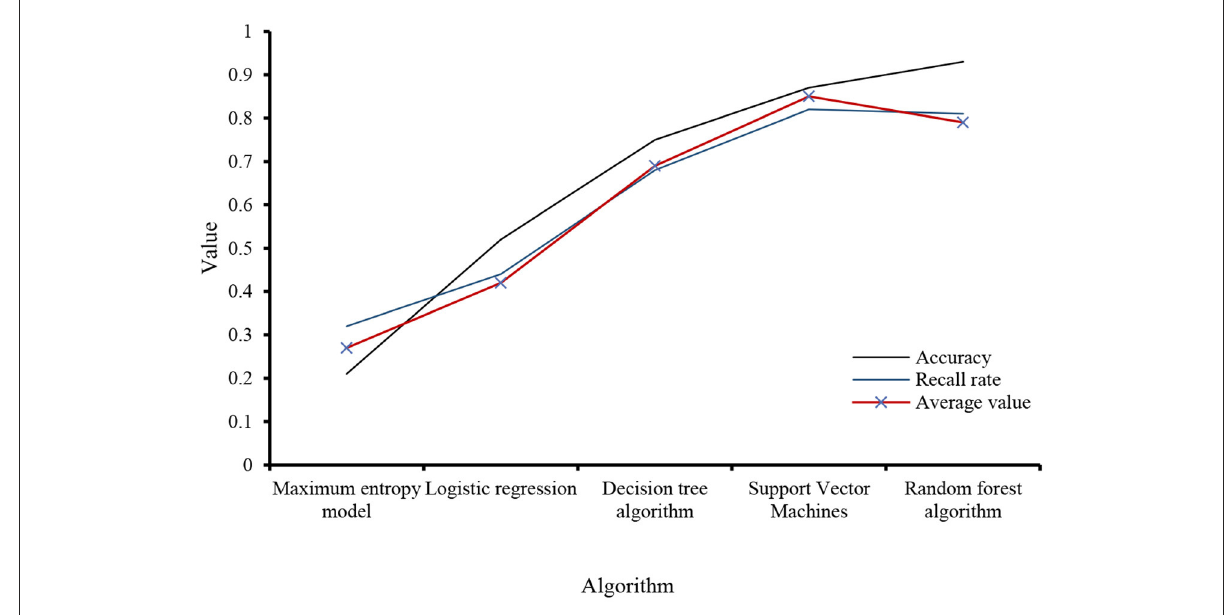
FIGURE5 Algorithm performance.